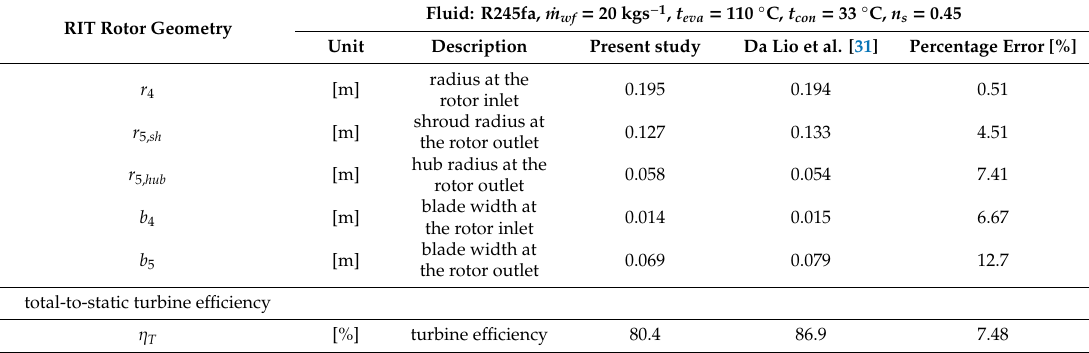
Table 3. Verification of proposed